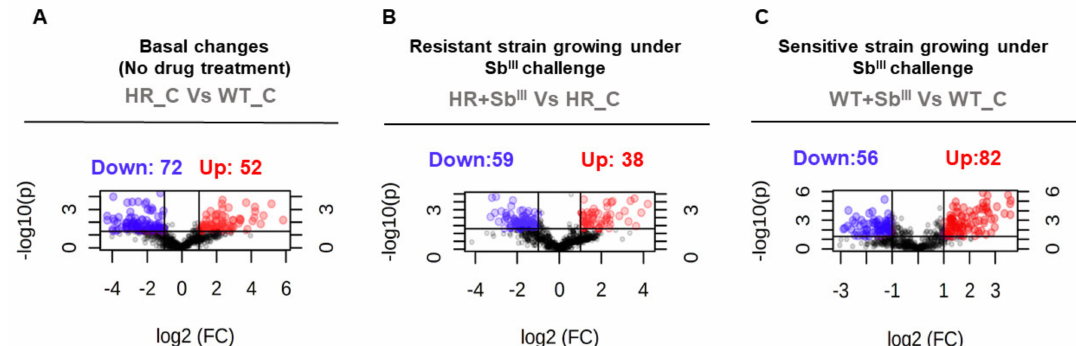
Figure 3. Volcano plots display significant differences at the lipid expression level in antimony resistant parasites. The volcano plots show the statistical significance ( p value) transformed by the negative base 10 logarithm in the Y -axis versus the fold change (FC) transformed by the binary logarithmic function in the X -axis. The data from three biological repeats were analyzed. Statistically significant changes in lipids were detected in the antimony resistant strain under basal conditions in the absence of drug ( A ), in the antimony resistant strain responding to Sb III ( B ), and in the antimony sensitive strain responding to Sb III ( C ). The differentially expressed lipid ions were filtered by the p -value cutoff ≤ 0.05 and the absolute fold change cutoff ≥ 2. Significantly downregulated and upregulated lipid ions are highlighted with blue and red dots respectively while lipids with no significant changes are showed in black